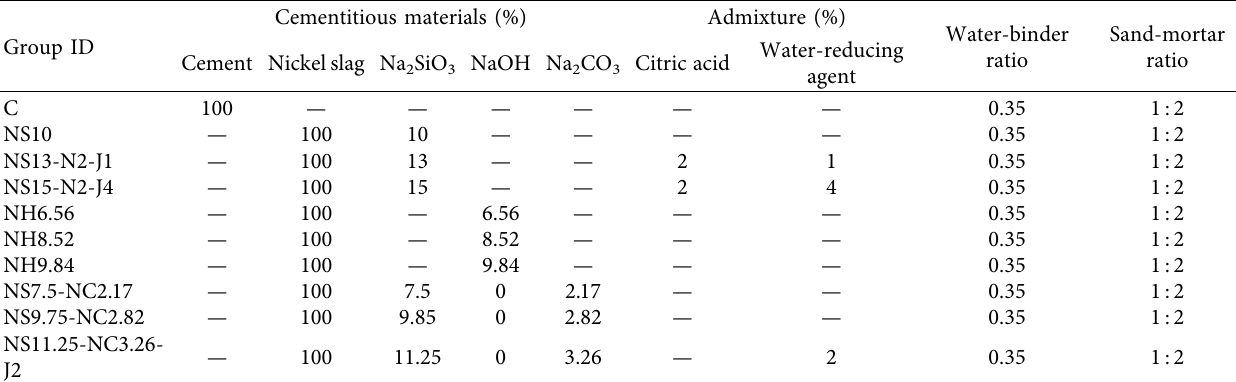
Table 2: Mix proportion of alkali-activated nickel slag mortar excited by different alkali activators. Cementitious materials (%) Group ID